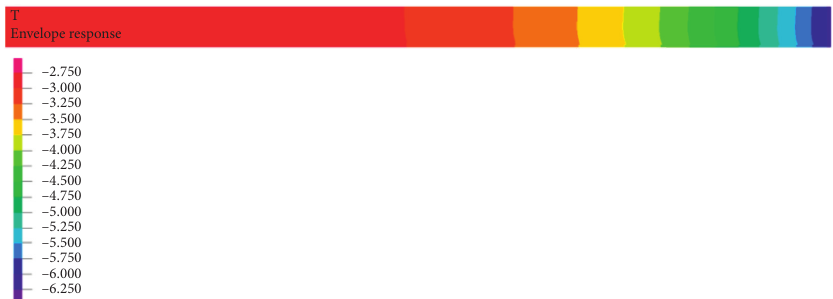
Figure 15: Annual average air temperature distribution in the tunnel axis with a thermal conductivity of 0W/(m · ° C).